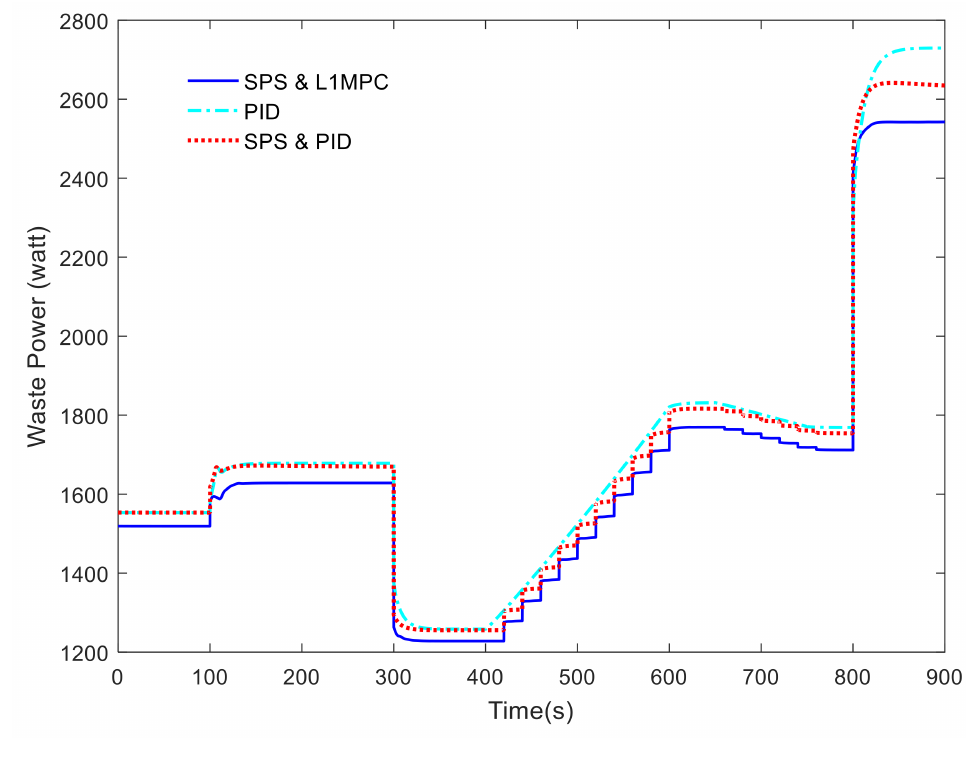
Figure 9. The waste power.